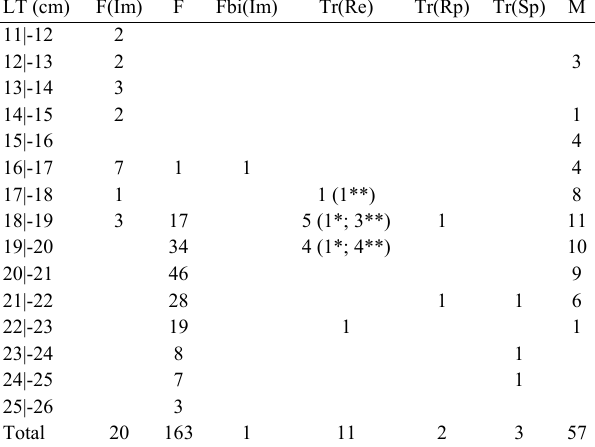
Pathways of protogynous hermaphroditism A single previous, available study for A. afer is that of Smith (1959) who classified it as a protogynous hermaphrodite and reported females ranging from 13.2 to 23.5 cm L and a T single male of 21.3 cm L . Our study from Brazilian reefs showed T mature males from 12 to 22 cm L and mature females from 16 T to 25 cm L , indicating that males are in average smaller than T females. Also, first maturity size of males at 12 cm L was T inferior to the size of first maturity of females at 18 cm L . T Males smaller than 17 cm L were considered primary males T because they did not show any signs of previous reproduction as females. The suggested reproductive pathways for A. afer are shown in Fig. 10. Reports of species,